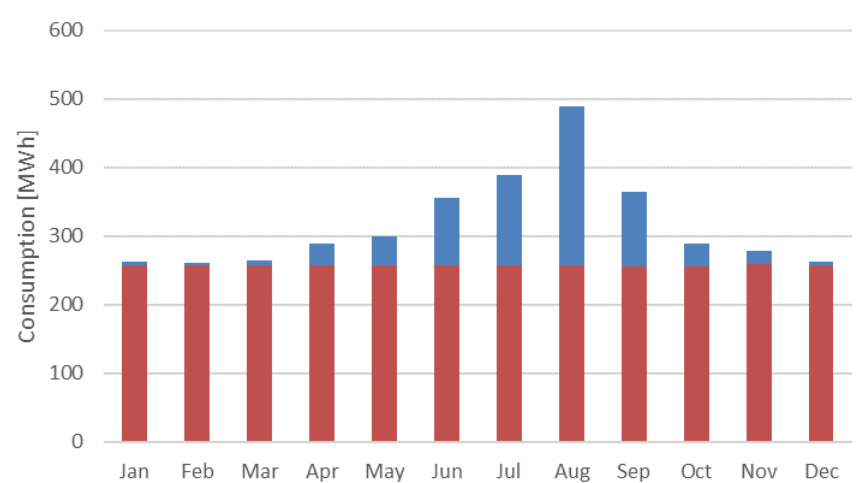
Figure 5. Annual trend of electricity consumption for Domestic Hot Water, DHW in the residential sector in Pantelleria in 2011 (The figure was elaborated by the authors based on data provided by SMEDE [87]).